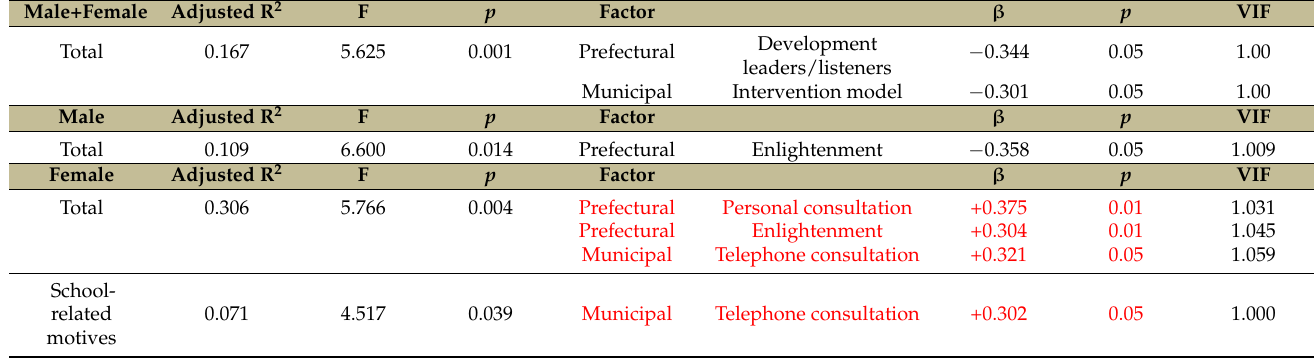
Table 3. Effects of funding for the sub-divisions of EFECBSC on Male+Female, male and female EBSMR trends of suicide mortality of school-aged population (total: suicide numbers of those younger than 20 years old/population of those younger than 20 years old) and caused by school-related motives (school-related motive: suicide numbers caused by school-related motives/population of those younger than 20 years old). The effects of the amount of funding provided to 10 EFECBSC sub-divisions on the EBSMR trends of Male+Female, males and females were analysed by forward multiple regression analysis. The red colour sub-divisions of the EFECBSC indicate negative effects on the prevention of suicide mortality. Male+Female Adjusted R